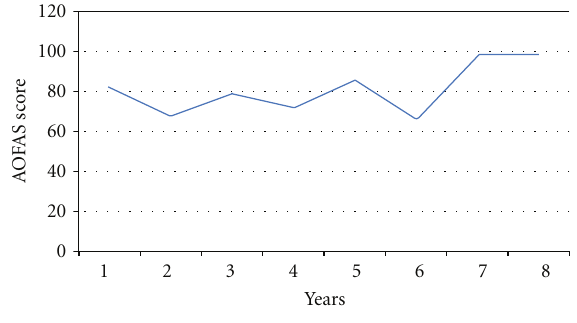
Figure 6: AOFAS score trend during follow-up.